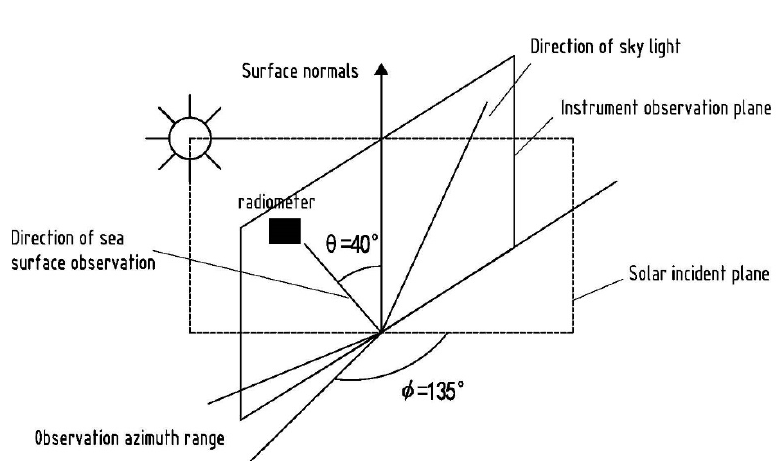
Figure 3. The geometric diagram of the above method.